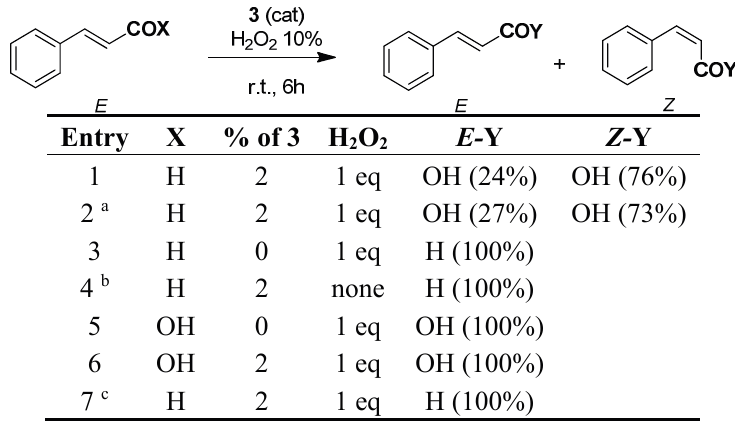
Table 3. Studies on the isomerization of cinnamic